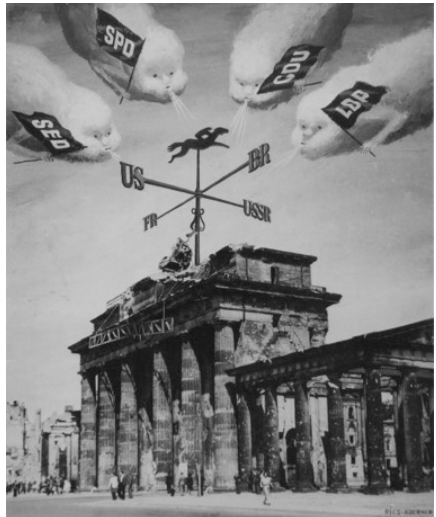
Figure 12. Henry Ries and Joseph Koerner. Fotografie des Titelmotivs des OMGUS Observer vom